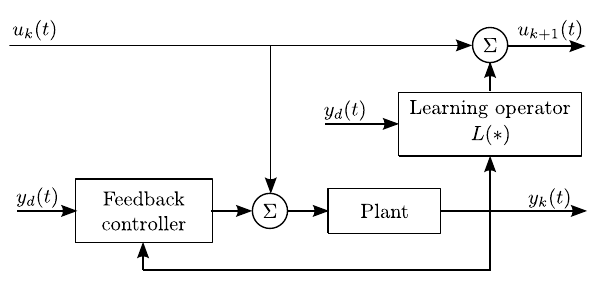
Figure 2: Learning control application with a feedback controller